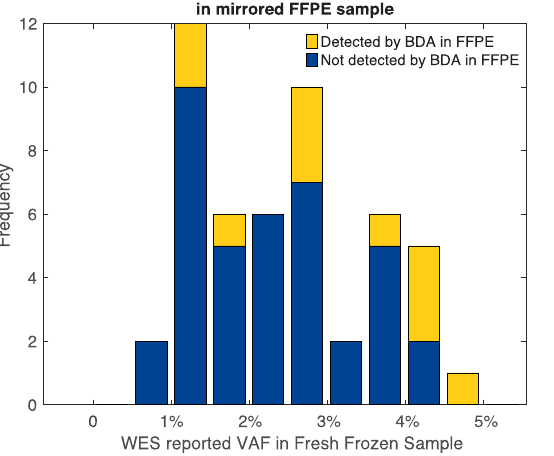
Figure 4. WES false-negative analysis. BDA qPCR/Sanger analysis was performed for 50 variants on the FFPE sample. By WES, those variants were detected with < 5% VAF in the fresh-frozen sample but not detected in the FFPE